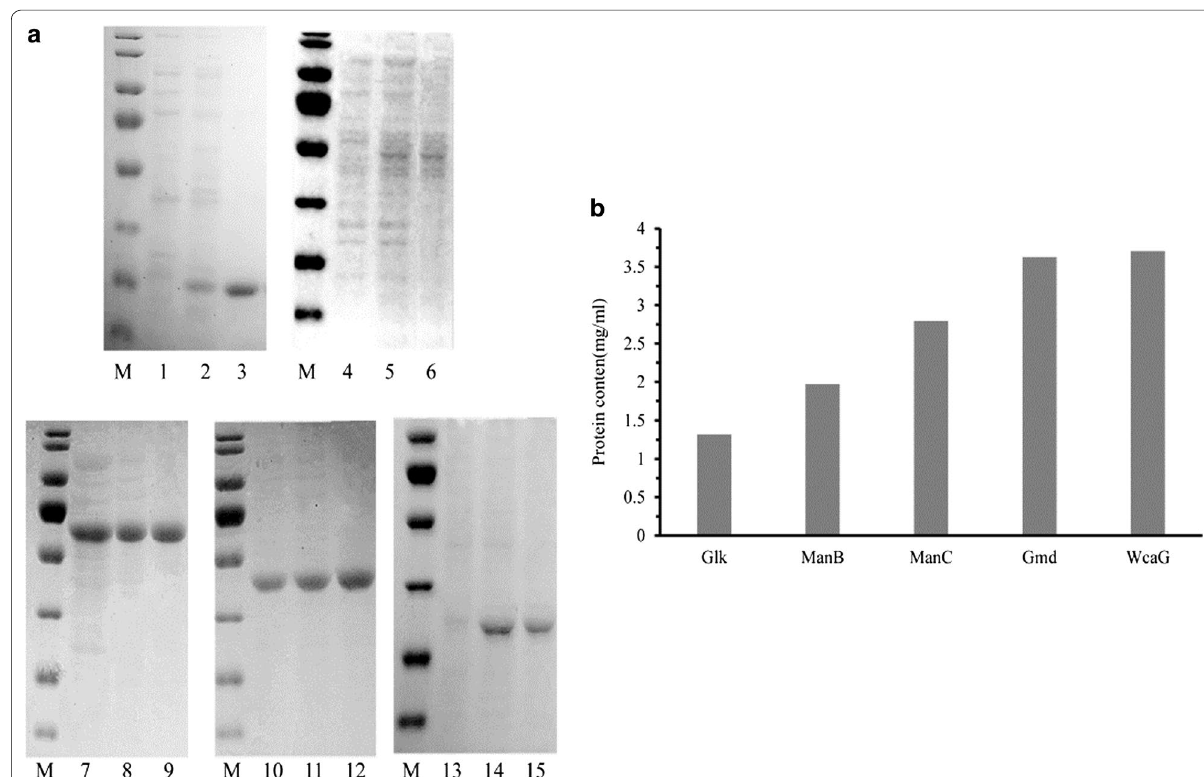
Fig. 2 a SDS-PAGE analysis of the recombinant GDP- l -fucose biosynthetic enzymes. Lane M: molecular weight marker; Lane 1–3: Glk ( ( IPTG), purified Glk; Lane 4–6: ManB ( + Gmd ( IPTG), Gmd ( IPTG), purified Gmd; Lane 13–15: WcaG ( − +